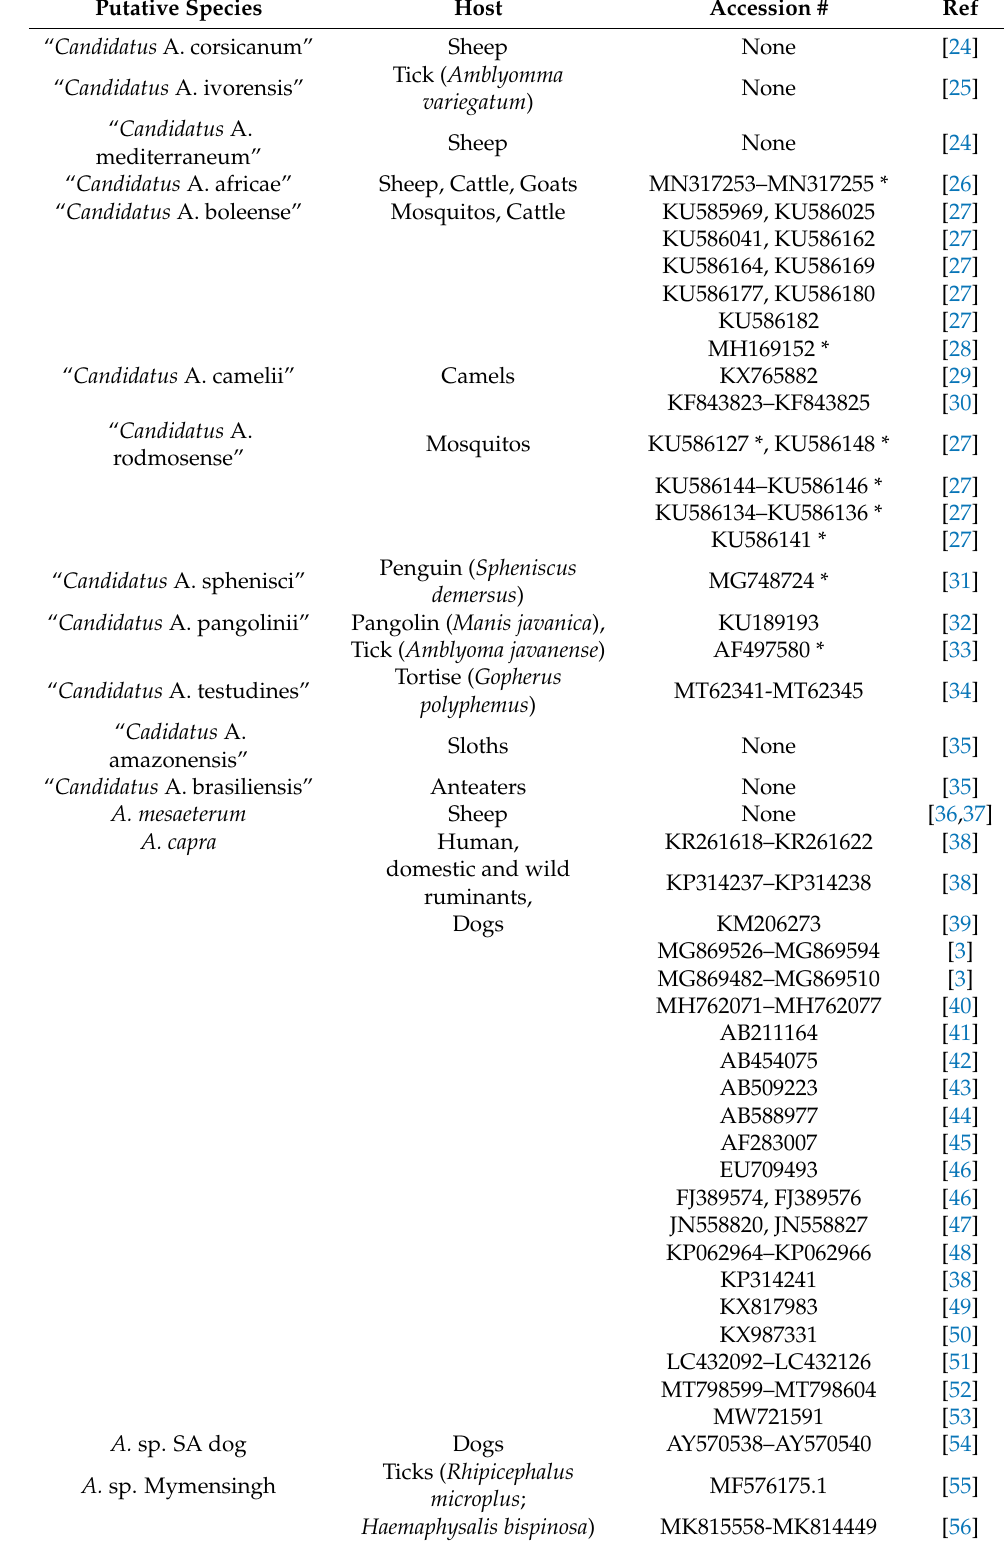
Table 2. Putative Anaplasma spp., host source, 16S rRNA sequence accession numbers and references. Putative Species